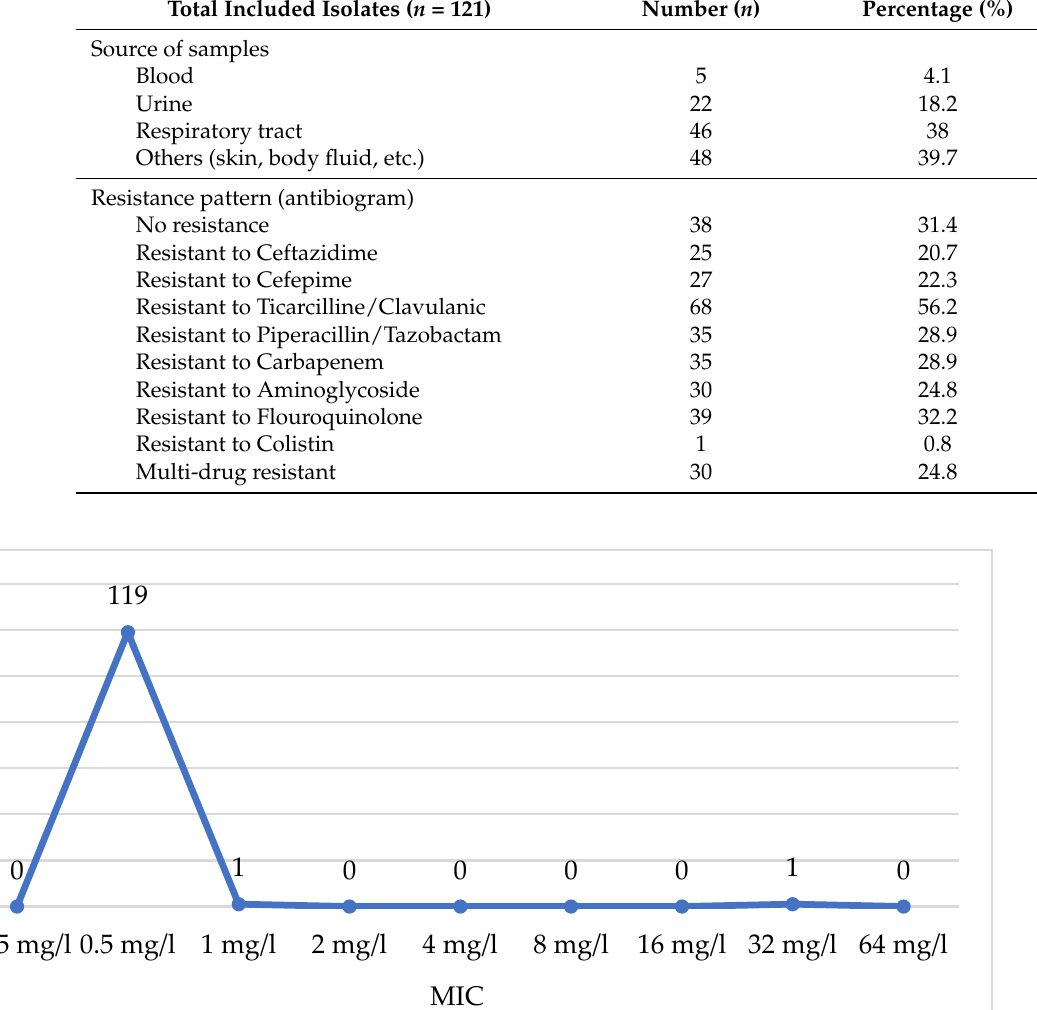
Table 3. Antimicrobial susceptibility test (AST) results of all P . aeruginosa isolates. Total Included Isolates ( n = 121)